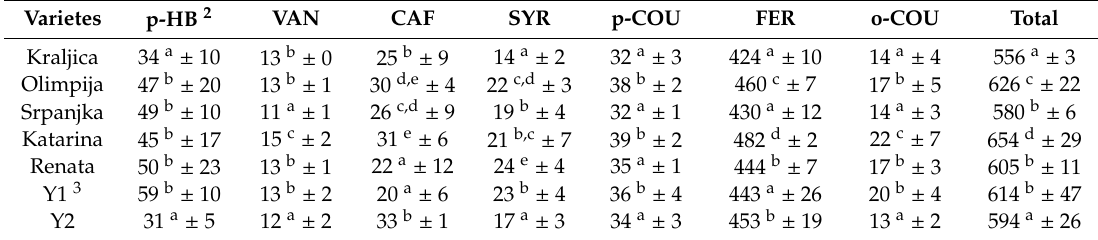
Table 3. Content 1 ( µ g / g dm ) of bound phenolic acids in wheat